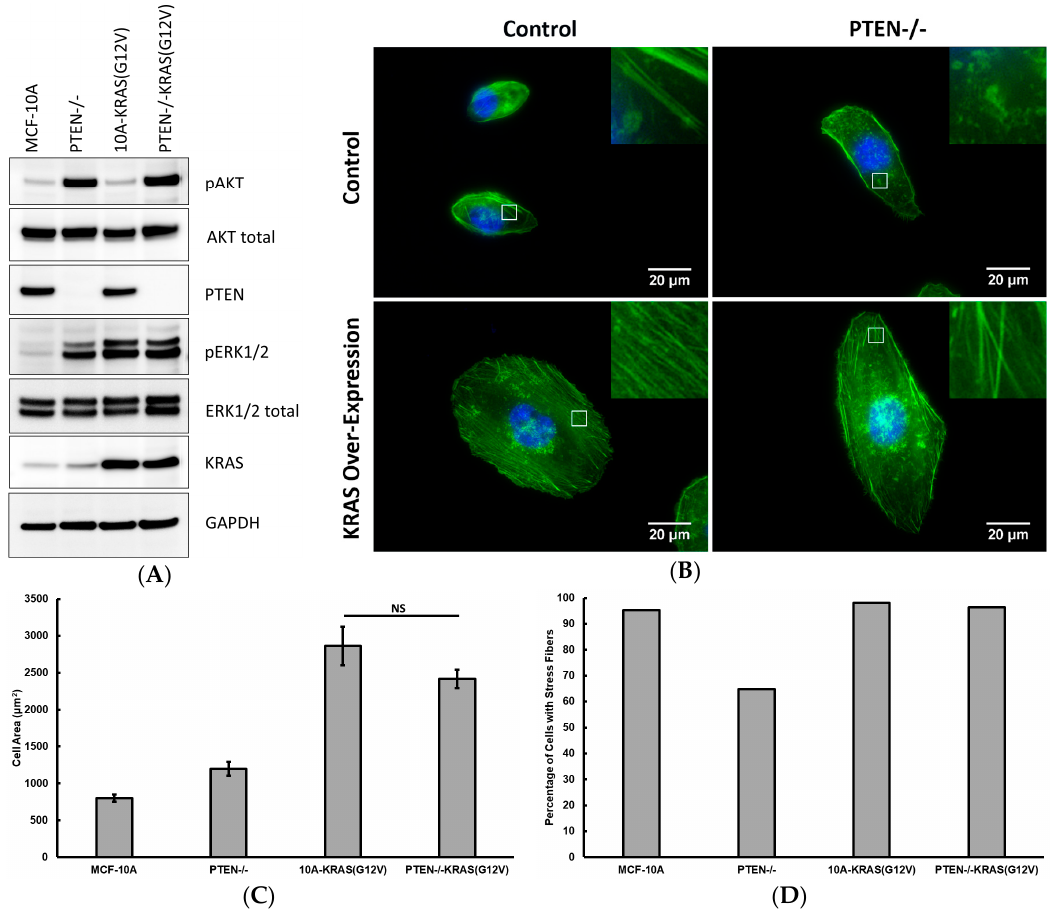
Figure 1. ( A ) Western blots of MCF-10A, PTEN − / − , 10A-KRAS(G12V), and PTEN − / − KRAS(G12V) cells highlighting proteins critical to the expression of the PI3K and Ras/MAPK pathways; ( B ) Immunofluorescence images of MCF-10A, PTEN − / − , 10A-KRAS(G12V), and PTEN − / − KRAS(G12V) cells stained with phalloidin (green) and DAPI (blue). Insets are zoomed views of the regions highlighted in the white boxes; ( C ) Average cell area and ( D ) percentage of cells with stress fibers for MCF-10A, PTEN − / − , 10A-KRAS(G12V), and PTEN − / − KRAS(G12V) cells. Number of cells measured: n = 50–63. NS signifies non-significant differences between two groups ( p > 0.05).